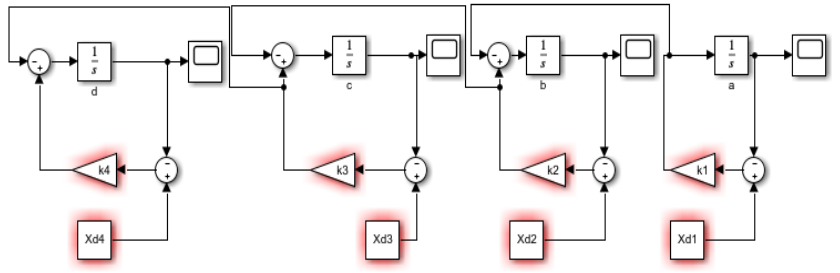
Figure 20. Block diagram for the cutting process, with n = 4.